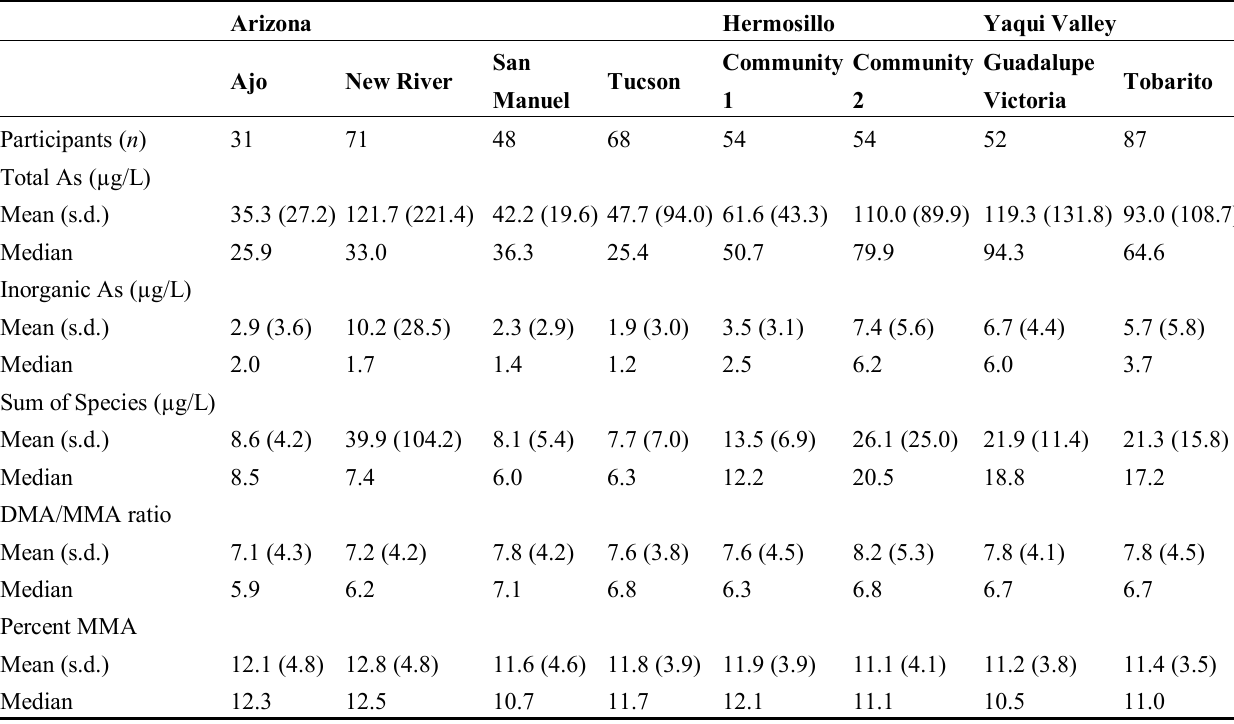
Table 5. Urinary Arsenic Concentration Adjusted for Specific Gravity among BAsES Participants by Recruitment Site. Arizona Hermosillo Yaqui Valley San Community Guadalupe Ajo New River Tucson Victoria